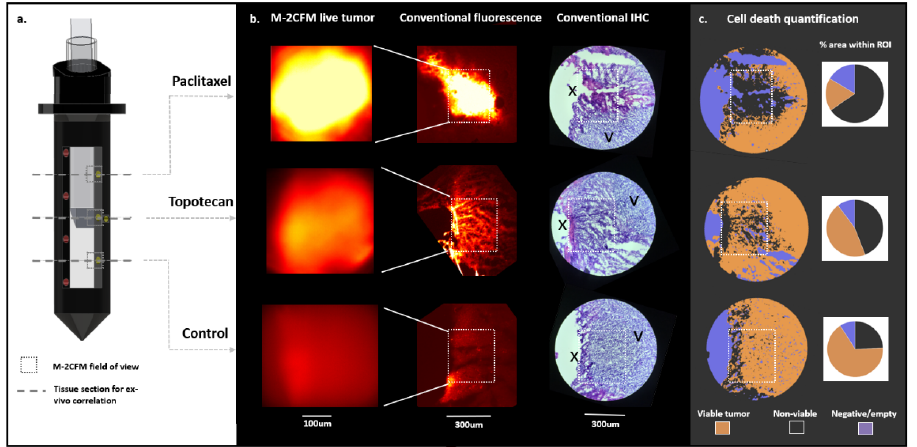
Figure 6. Methodology to correlate live tumor imaging with gold standard ex vivo fluorescence imaging and immunohistochemistry, demonstrated in a representative tumor sample. ( a ) After completion of live tumor imaging for 8 h, cross sections of tumor tissue (dashed lines) were obtained at each drug delivery site. ( b ) fluorescent signal from M-2CFM imaging in live tumor tissue (first column) was compared with corresponding conventional benchtop fluorescence microscopy (sec- ond column) and immunohistochemistry (IHC) (third column), imaged after sectioning and processing the tissue. On the benchtop fluorescence and IHC images, the boxes indicate the ~400 × 300 μ m region of interest (ROI) corresponding to the region of tissue imaged by the M-2CFM probe in the live tumor. On the IHC image, the ‘X’ denotes site of drug release; the ‘V’ indicates viable tumor tissue. ( c ) A trained image classifier enables quantitative determination of a non-viability index,